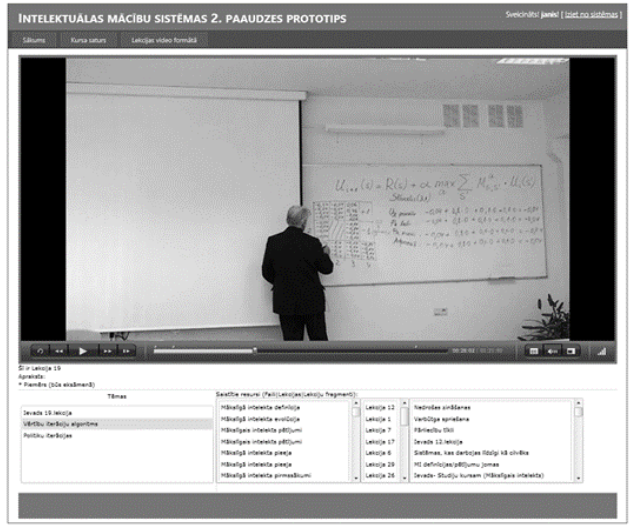
Fig. 2. ITS Lecture video player